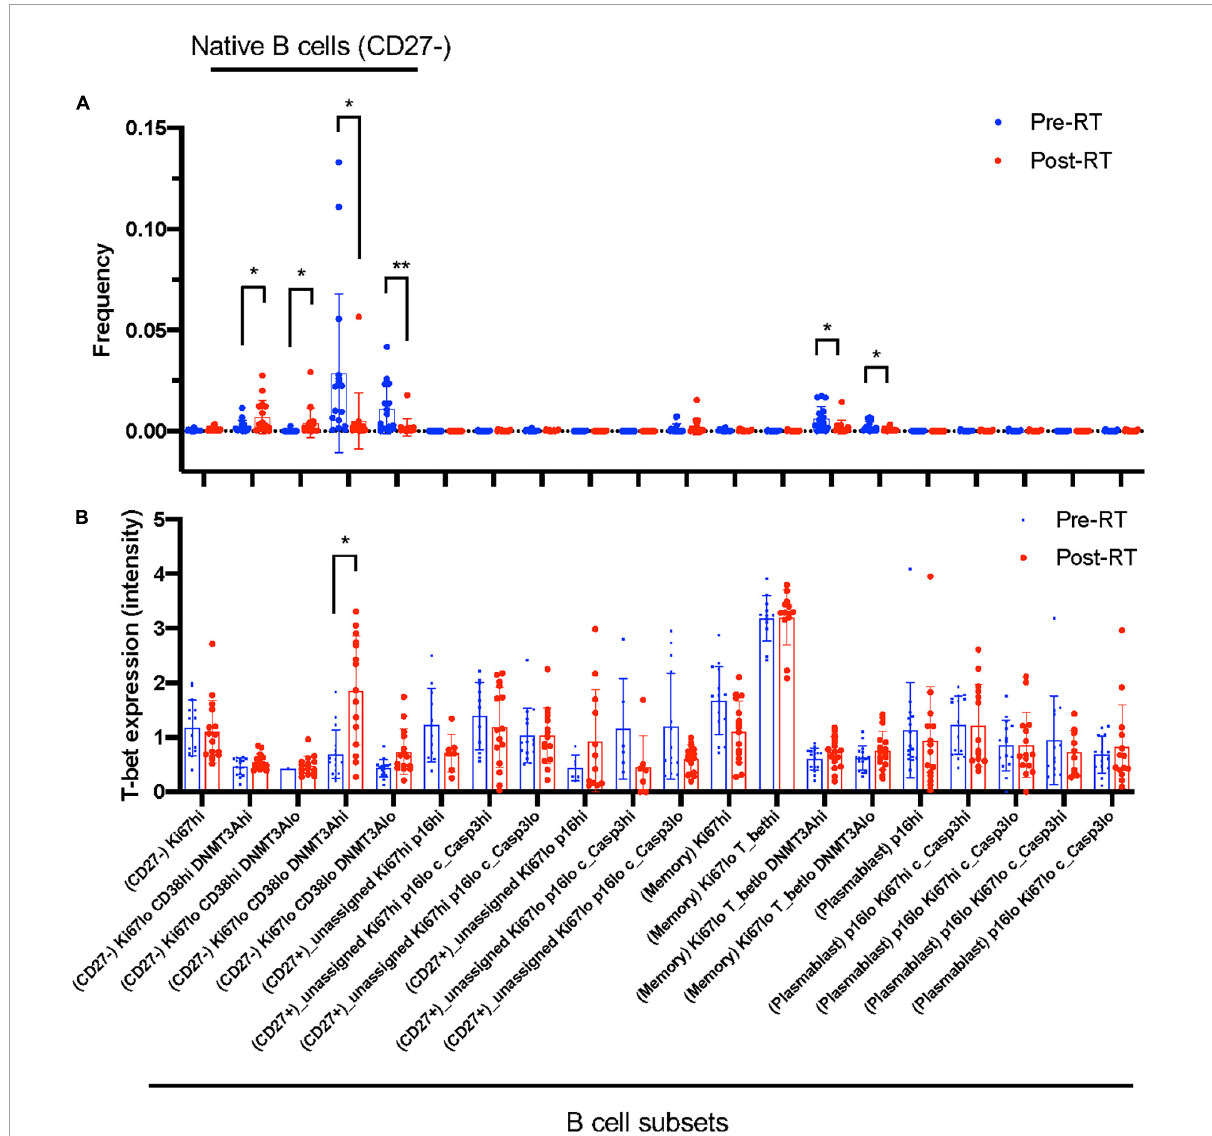
FIGURE3 B cell profiling subset and T-bet expression. (A) The frequency of each B cell profiling subset for all the cells in an experiment at pre-RT and post-RT. * p < 0.05 (or ** p < 0.01) by Student’s t -test, –log(FDR) > 0.5 and log(FC) < –1 or 1 < log(FC). (B) T-bet expression in each B cell profiling subset. The significant increase of T-bet expression after RT was observed only in the Ki67 − DNMT3a + naïve B cell subset. Mean ± SD, *adj. P -Val <